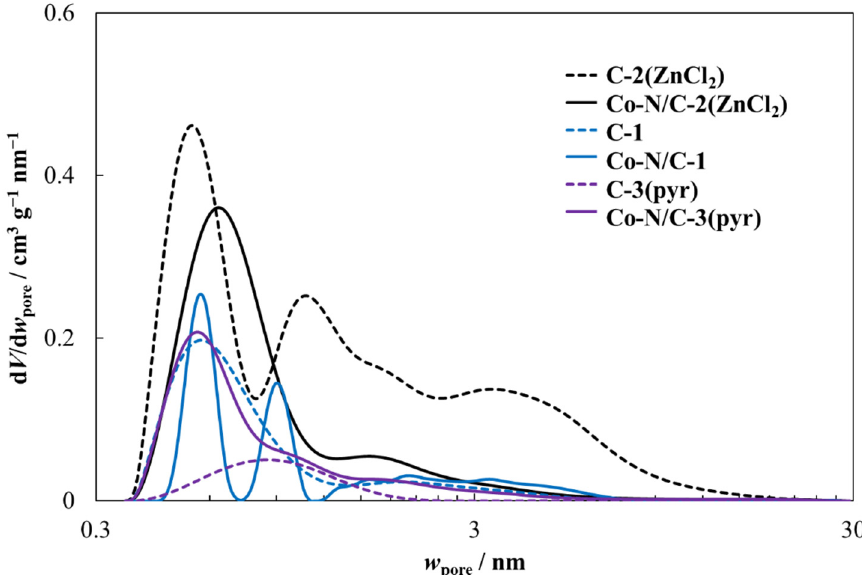
Figure 6. Calculated pore size distribution data for selected undoped and co-doped materials (noted in Figure).